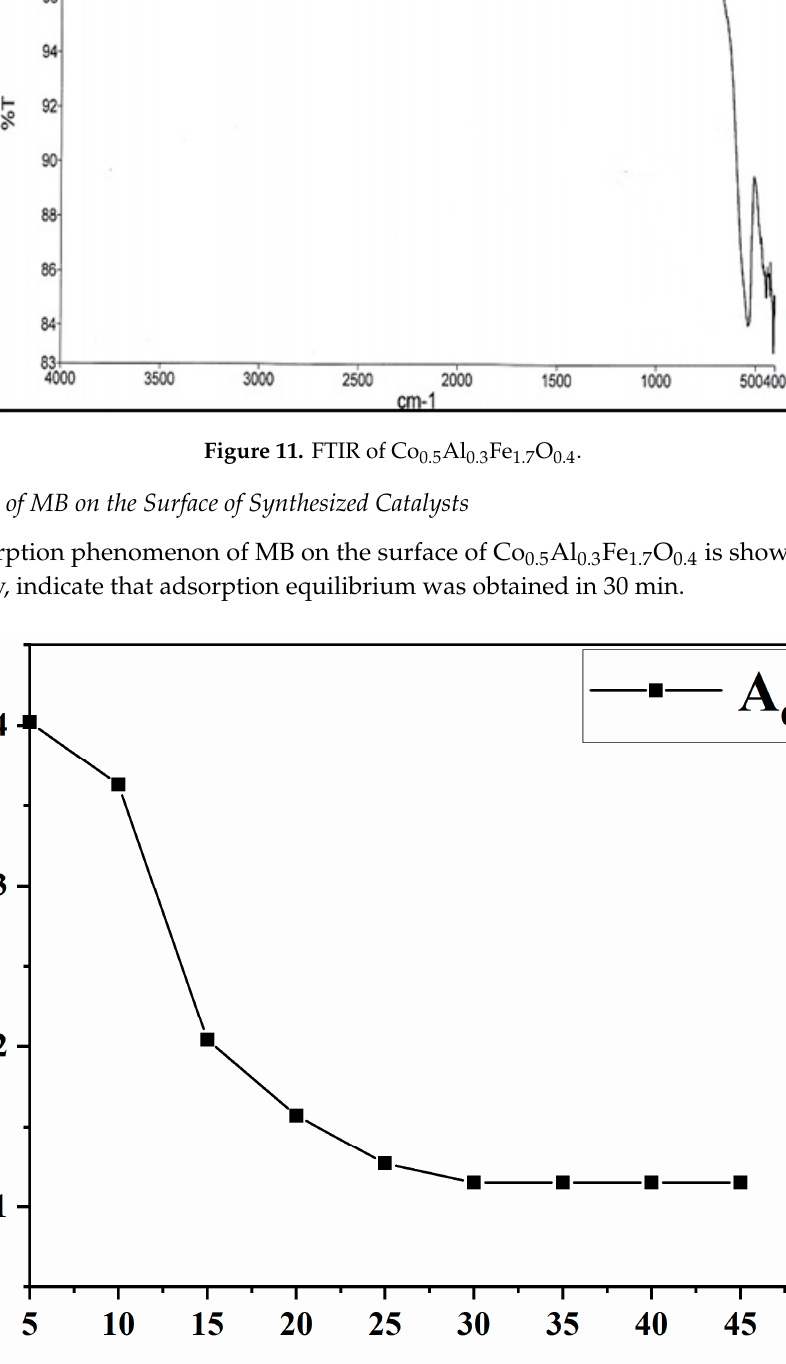
Figure 12. Adsorption of methylene blue (MB) on Co 0.5 Al 0.3 Fe 1.7 O 0.4.